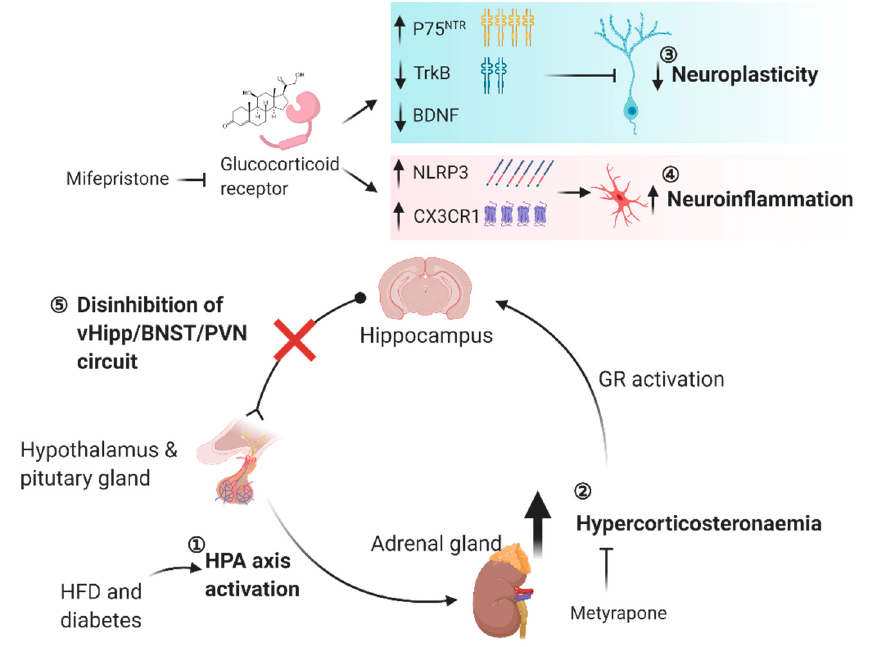
Figure 3. Obese and diabetic conditions disinhibit the hippocampal inhibitory control over the HPA axis. ① HPA axis hyperactivation is reported in diet-induced obese and diabetic conditions, resulting in ② increased corticosterone synthesis and secretion. Corticosterone can cross the blood-brain barrier and activates the glucocorticoid receptors in the hippocampus. The activation of the glucocorticoid receptor ③ impairs neuroplasticity and ④ promotes neuroinflammatory response. ⑤ The hippocampus is shown to inhibit the HPA activity through the vHipp/BNST/PVN neural circuit pathway, whereas dysregulated hippocampal plasticity may disinhibit the HPA axis and aggravates the diet-induced hyperactivation of the HPA axis. Created with BioRender.com.